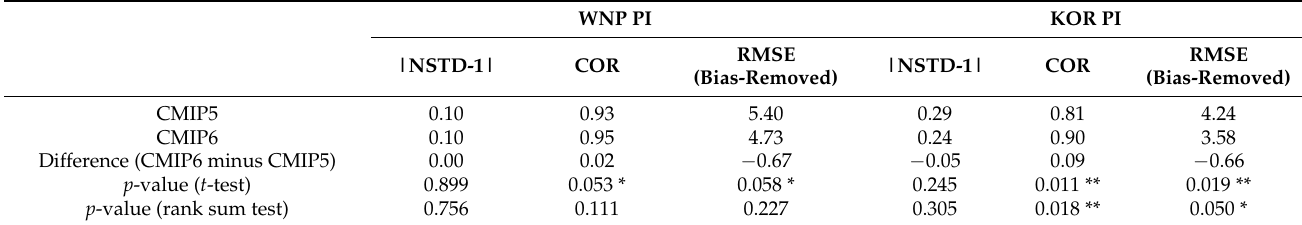
Table 2. Average of absolute departures of NSTDs from the baseline (|NSTD-1|), CORs and bias-removed RMSEs for CMIP5 and CMIP6 models, and their differences. The p -values for the differences calculated using the Student’s t -test and Wilcoxon rank sum test are also listed. The single and double asterisks indicate statistical significance at the 90% and 95% confidence levels,